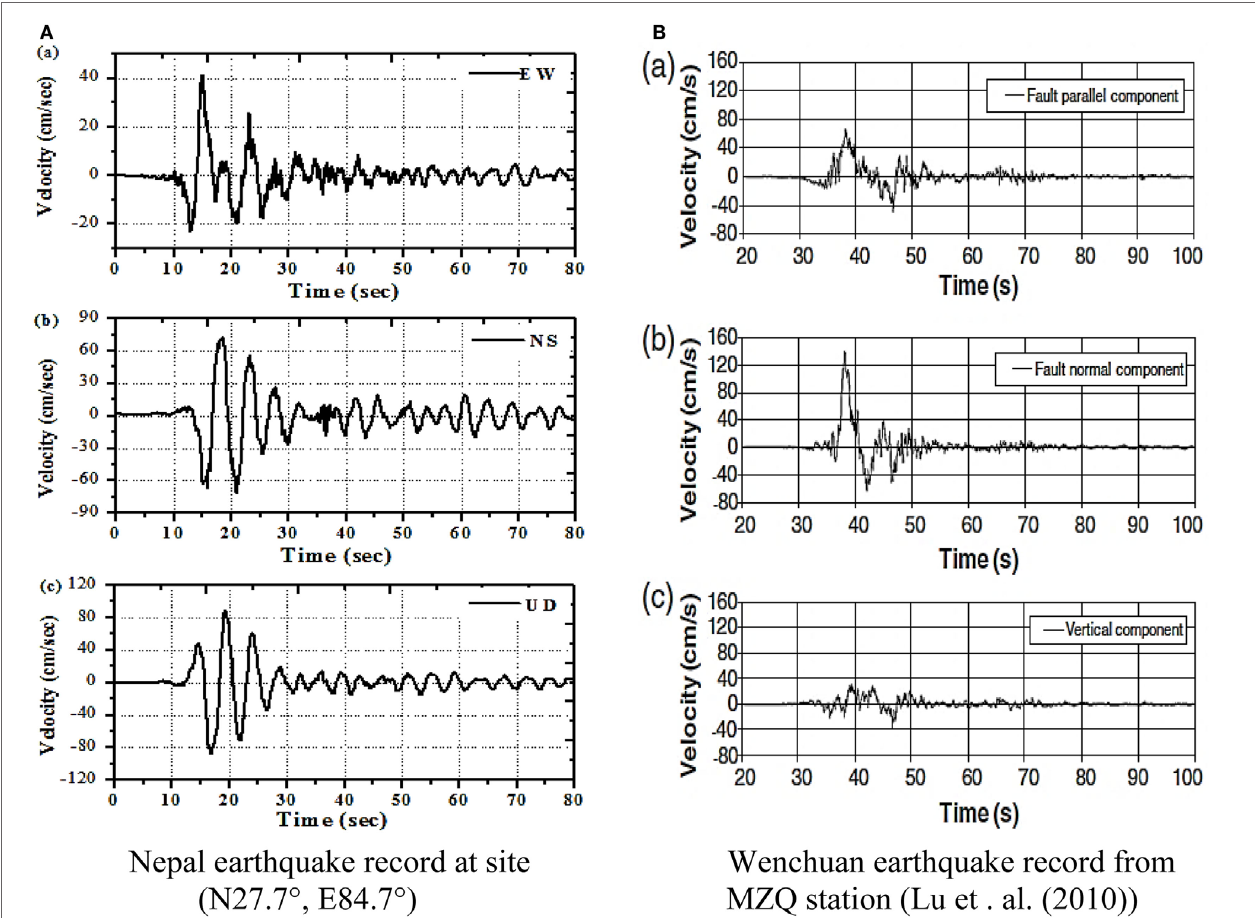
FigUre 3 | Velocity time histories of near-fault strong ground motions (a) nepal earthquake record at site (n27.7 ° , e84.7 ° ), (B) Wenchuan earthquake record from MZQ station lu et al. (2010) .